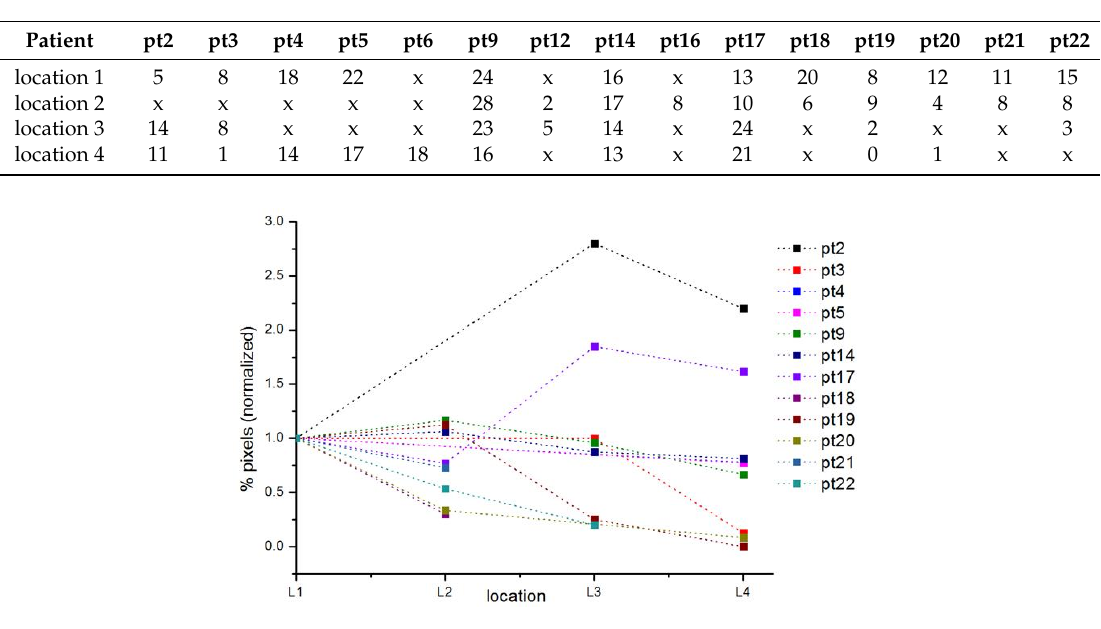
Figure 8. Normalized percentage of pixels per patient per location obtained from the OCT M-mode scans. The values are normalized relative to location 1, hence only the plots for patients with a value for location 1 are shown.